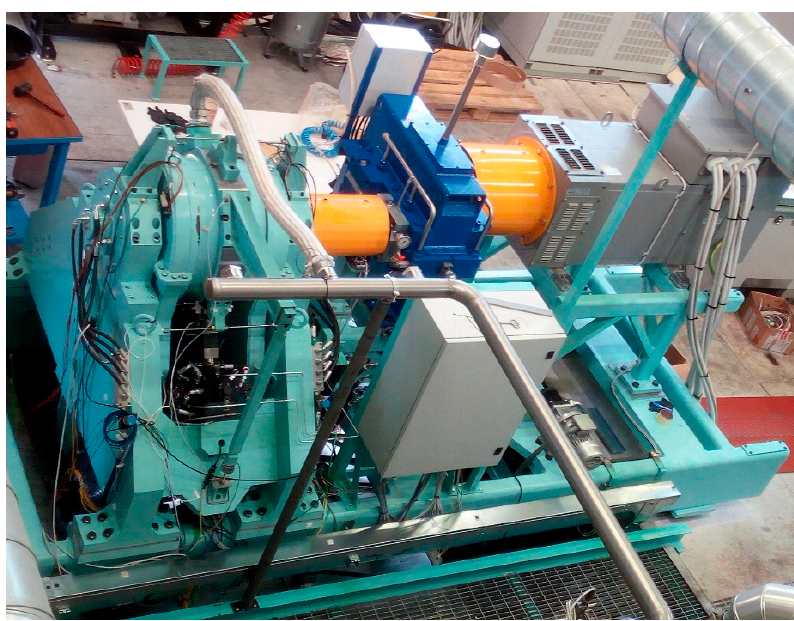
Figure 2. Photograph of the test rig.